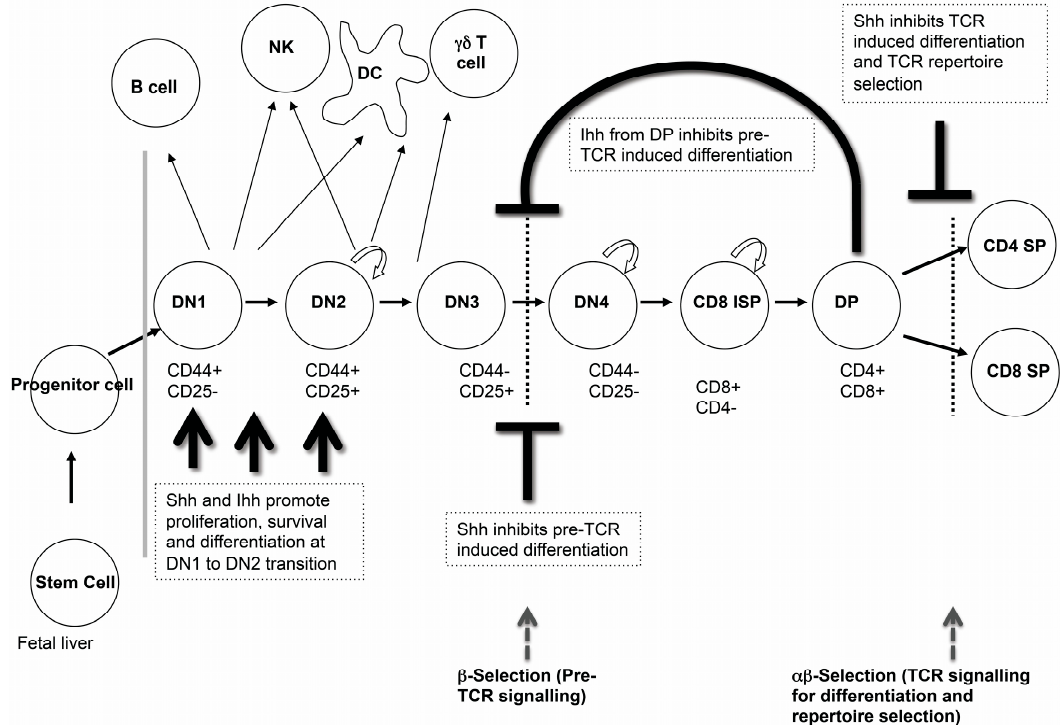
Figure 3. Hh signalling regulates multiple stages of thymocyte development. The cartoon illustrates the different stages of thymocyte differentiation that are regulated by Hh signalling in the embryonic thymus. (TCR: T cell